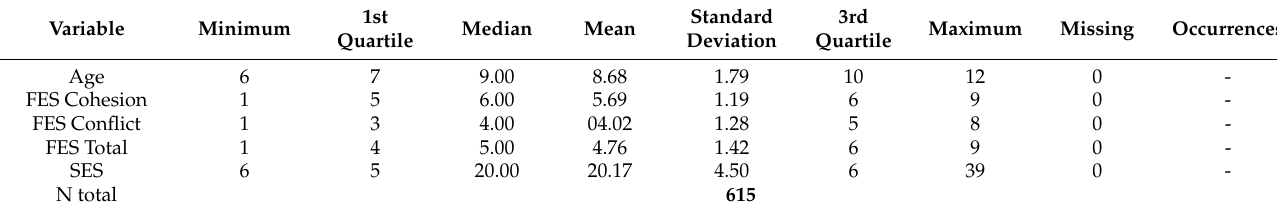
Table 1. Summary statistics of key